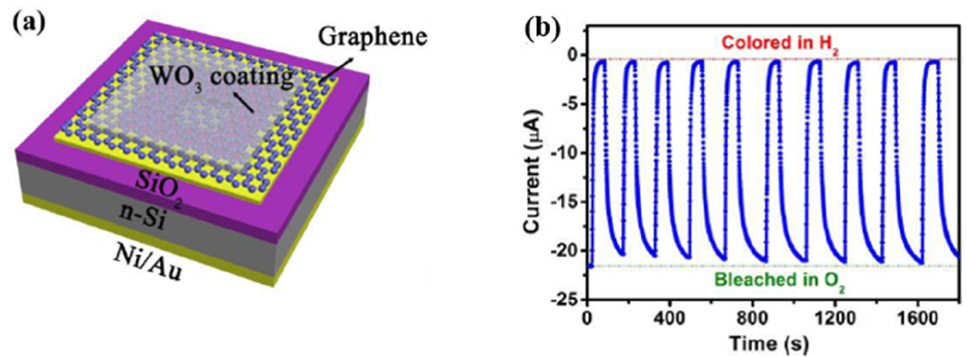
Figure 46. ( a ) Schematic of the optoelectronic Pd-WO 3 /Graphene sensor. ( b ) Cyclic performance of the device [209]. Copyright (2018), with permission from